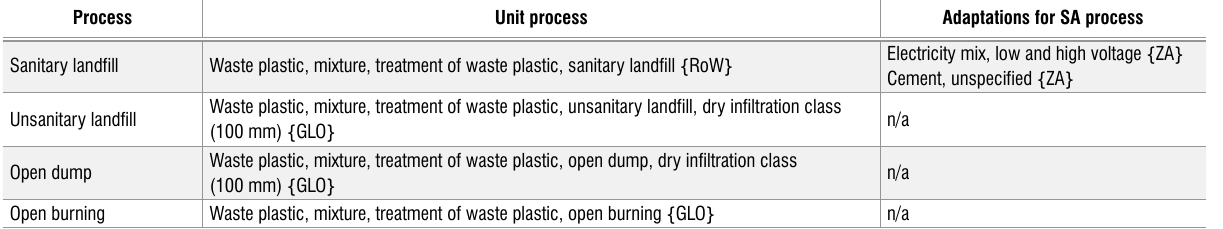
Table 3: Data source and adaptations for end-of-life processes Process